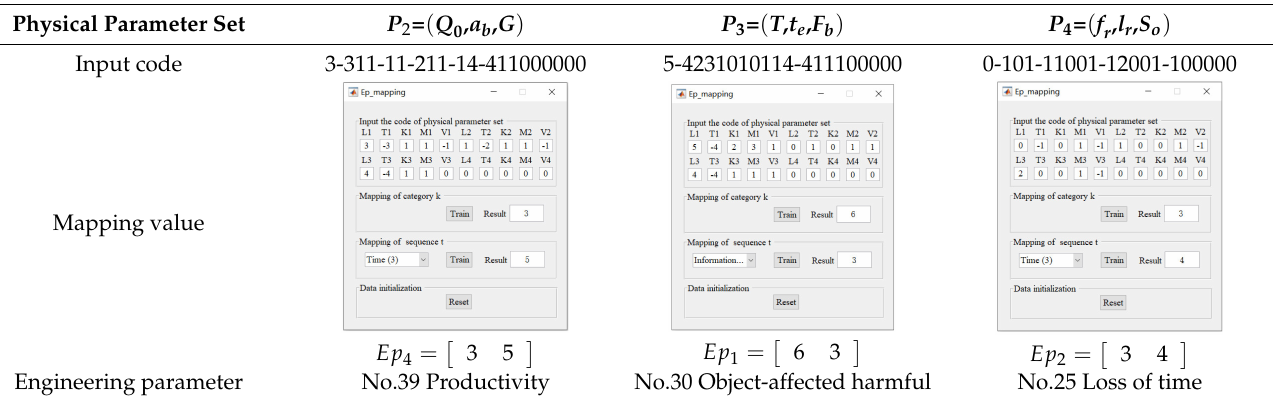
Table 10. Mapping results of engineering